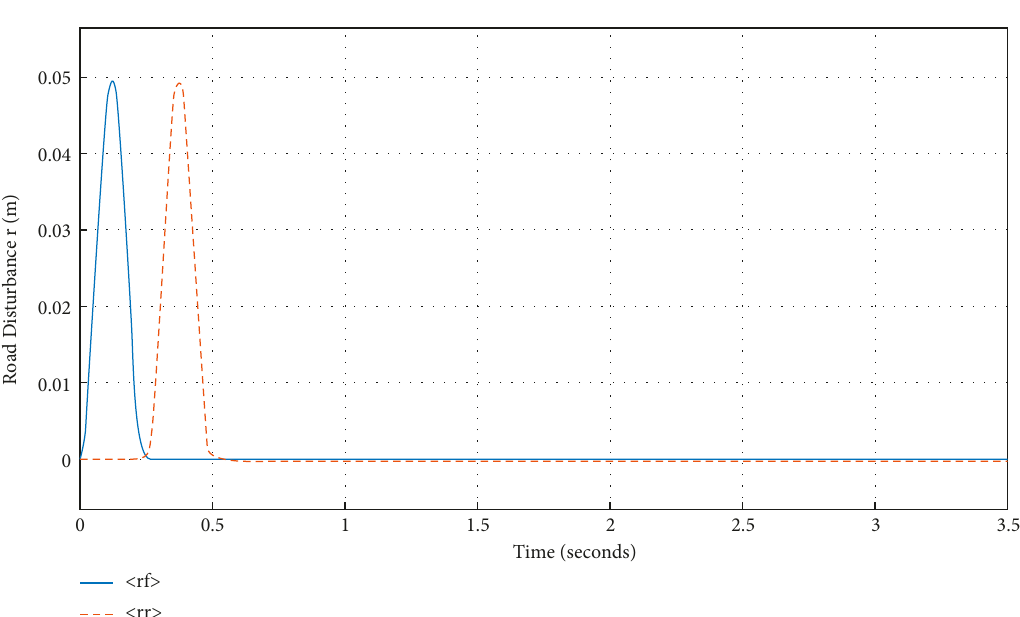
Figure 4: Road disturbance affecting the front and rear